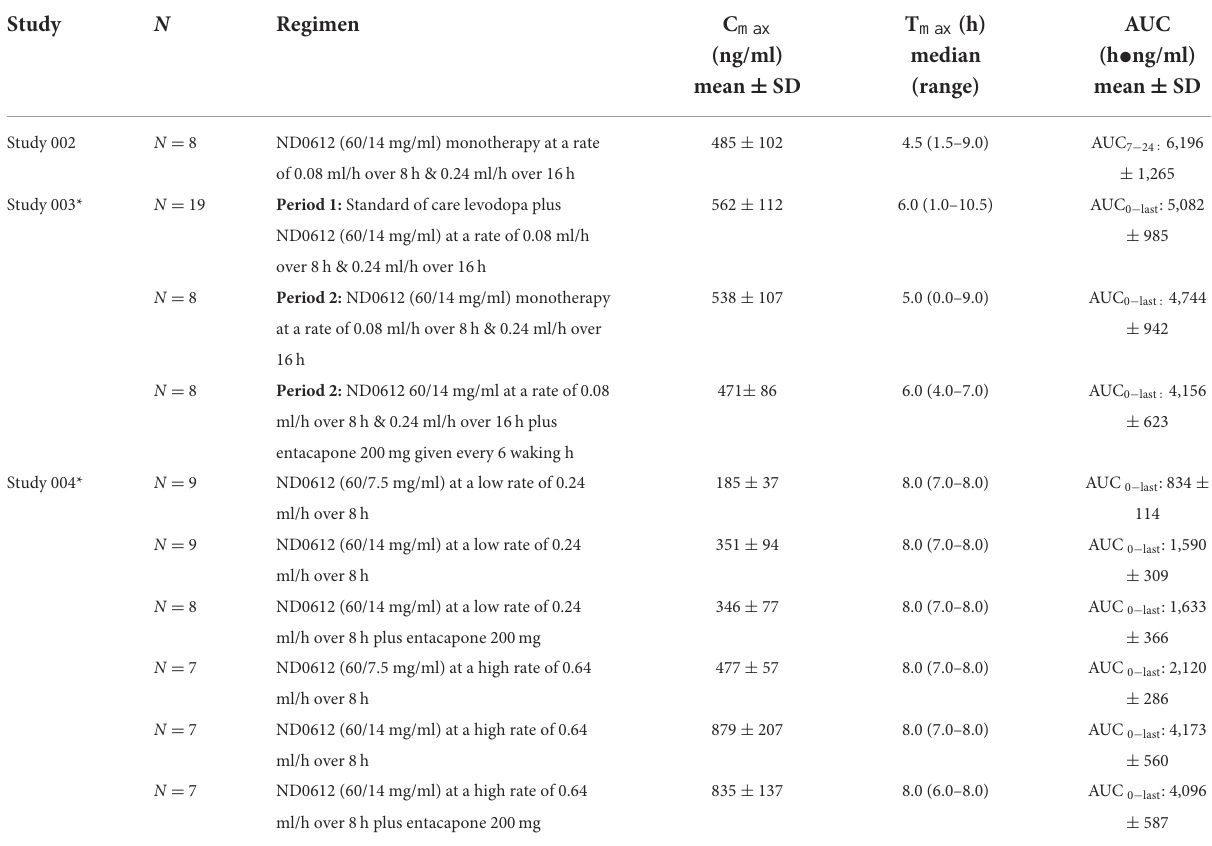
TABLE 3 ND0612 carbidopa pharmacokinetics in patients with Parkinson’s